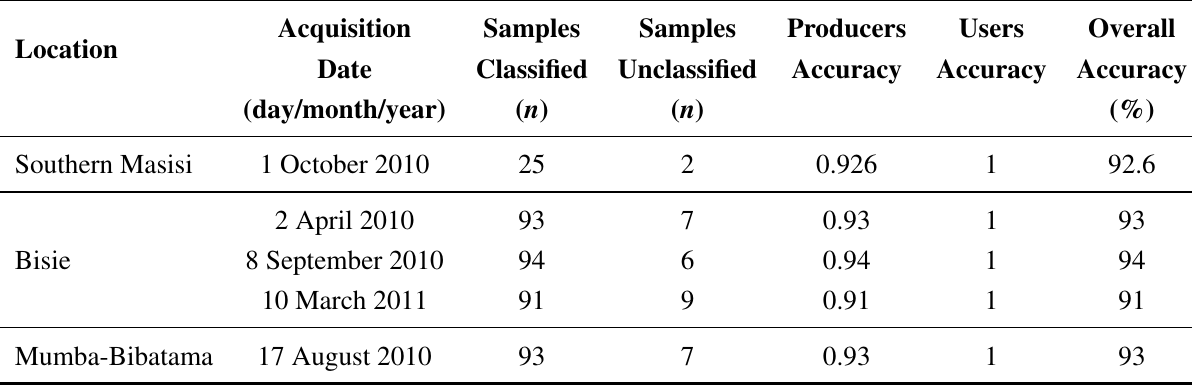
Table 3. Accuracy assessments of all imageries